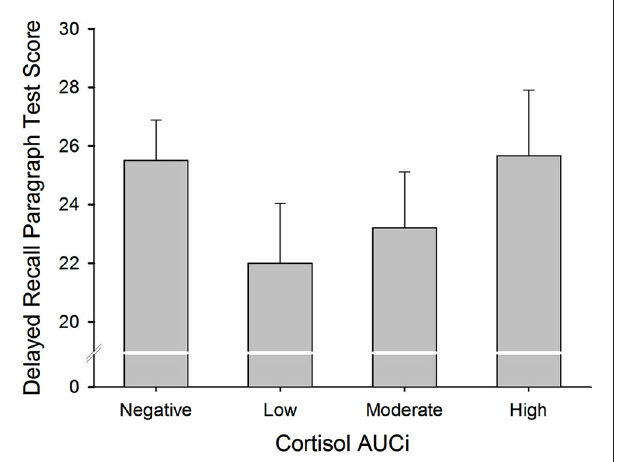
FIGURE 2 | Delayed Paragraph Recall performance and cortisol reactivity to stress. Participants were divided into four groups: (i) Negative AUCi; (ii) Low: first tertile positive AUCi; (iii) Moderate: second tertile positive AUCi; and (iv) High: third tertile positive